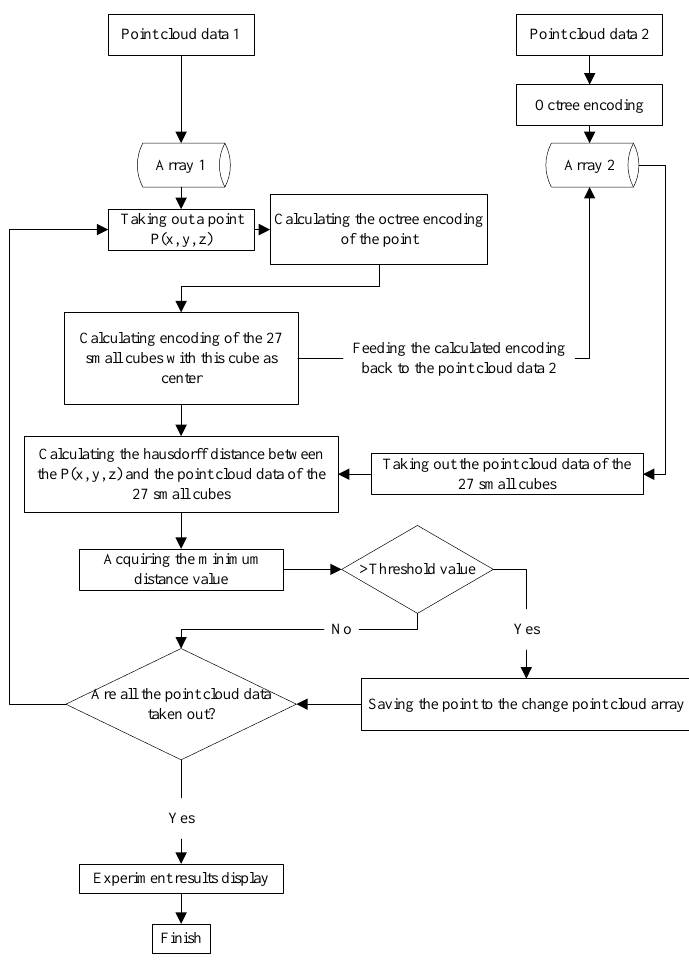
Figure 15. The overall damage detection process.